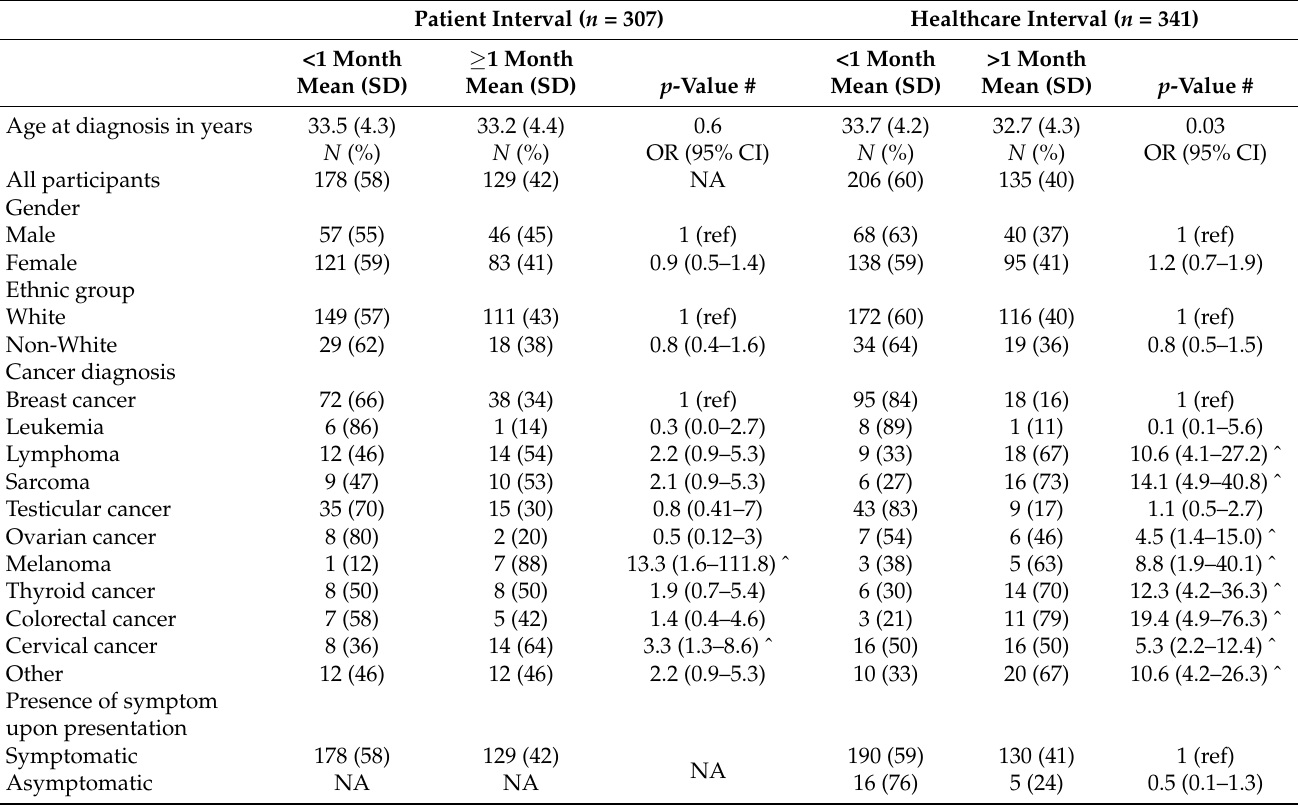
Table 2. Participant characteristics by interval